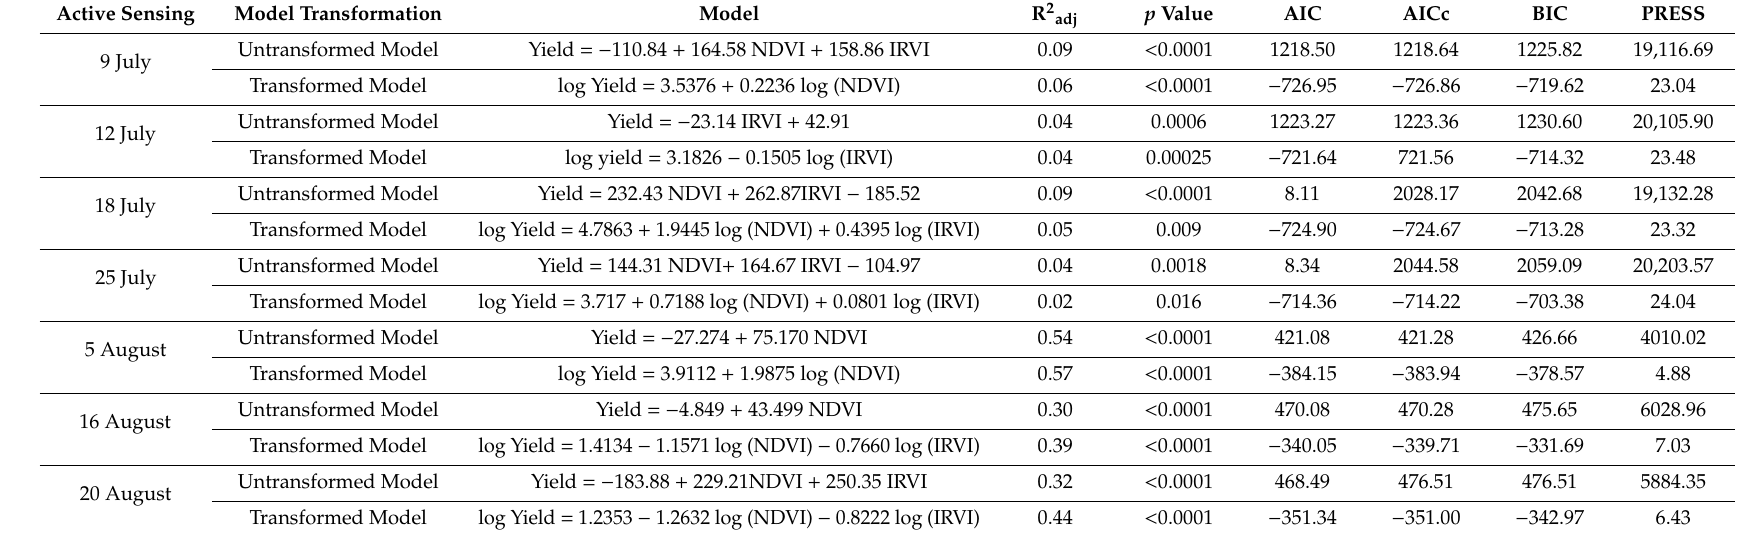
Table 6. Total potato yield models with an adjusted coe ffi cient of determination (R 2 adj ), p Value, AIC, AICc, BIC, and PRESS for GreenSeeker ™ . Active Sensing Model Transformation